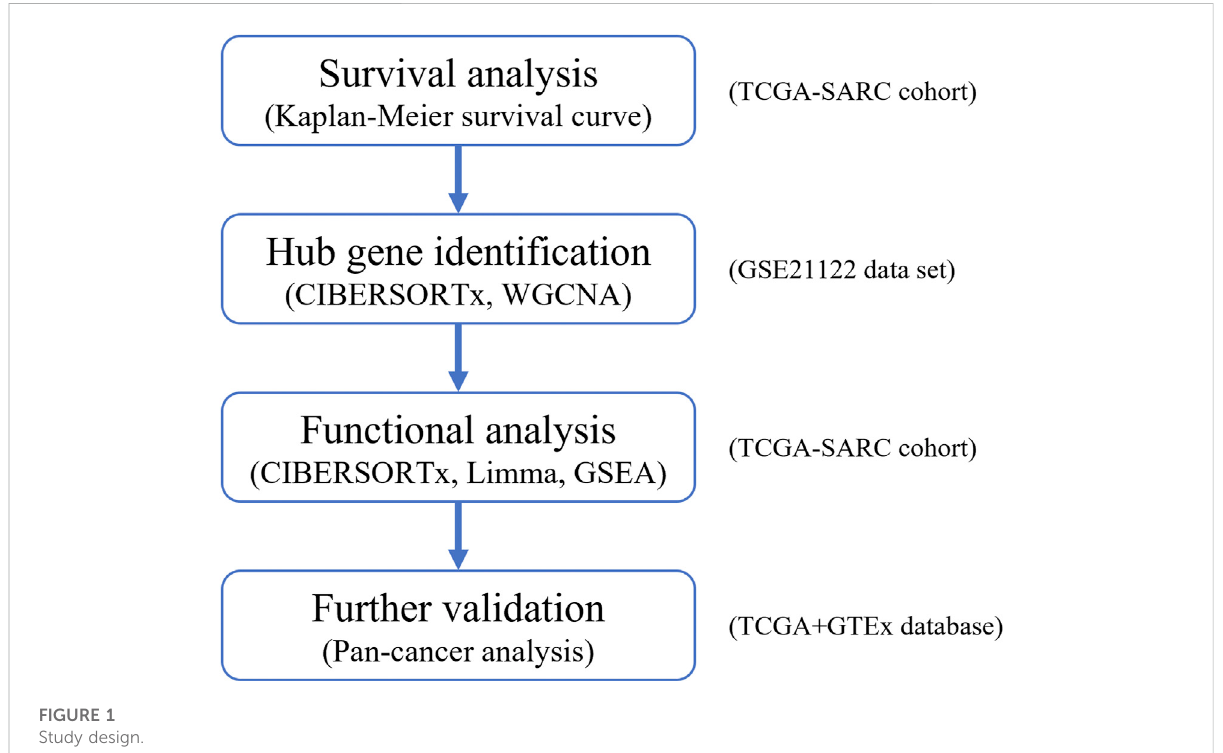
FIGURE 1 Study design.